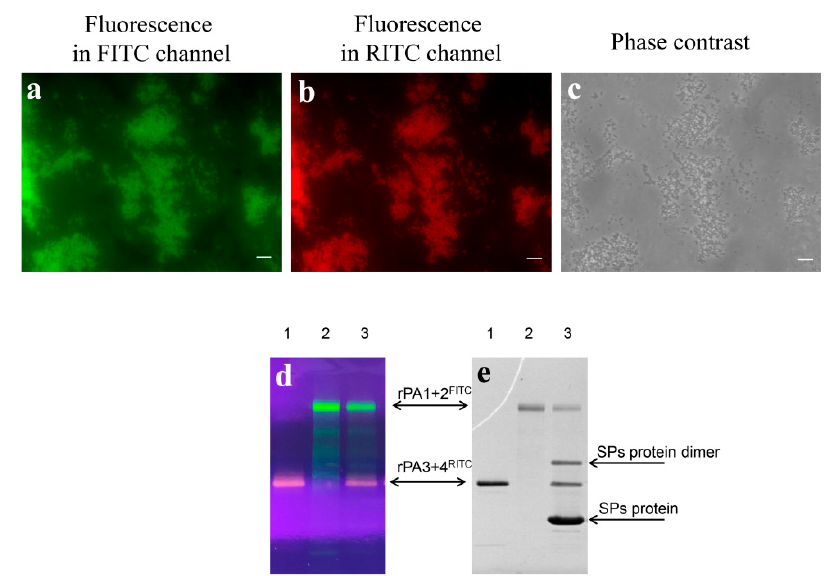
Figure 6. Simultaneous adsorption of rPA1+2 and rPA3+4 to SPs. ( a – c )—Fluorescence microscopy of rPA1+2 labelled with fluorescein isothiocyanate (rPA1+2 FITC ) and rPA3+4 labelled with rhodamine isothiocyanate (rPA3+4 RITC ) simultaneously adsorbed to SPs. Images are presented in FITC fluorescence channel ( a ), RITC fluorescence channel ( b ) and phase contrast mode ( c ). Images of control samples (SPs compositions with rPA1+2 FITC or rPA3+4 RITC separately and uncoated SPs) fluorescence analysis are presented in the Figure S4. ( d , e )—Electrophoresis analysis of modified recombinant anthrax antigens labelled with fluorophores in 8–20% SDS-PAGE. 1—rPA3+4 RITC ; 2—rPA1+2 FITC ; 3—Compositions of rPA3+4 RITC and rPA1+2 FITC with SPs. Unstained gel under UV-light ( d )